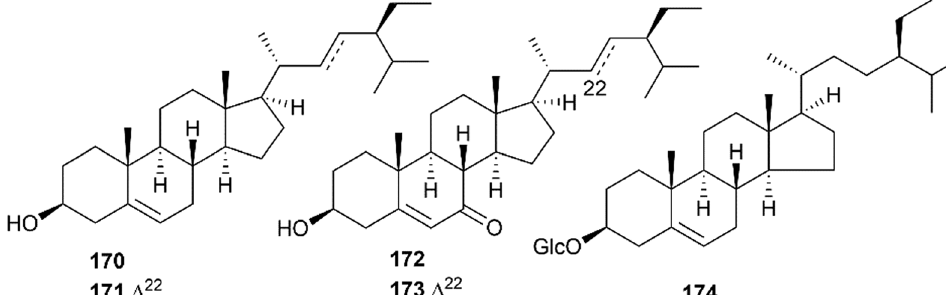
Fig.7 Steroids isolated from Euodiae